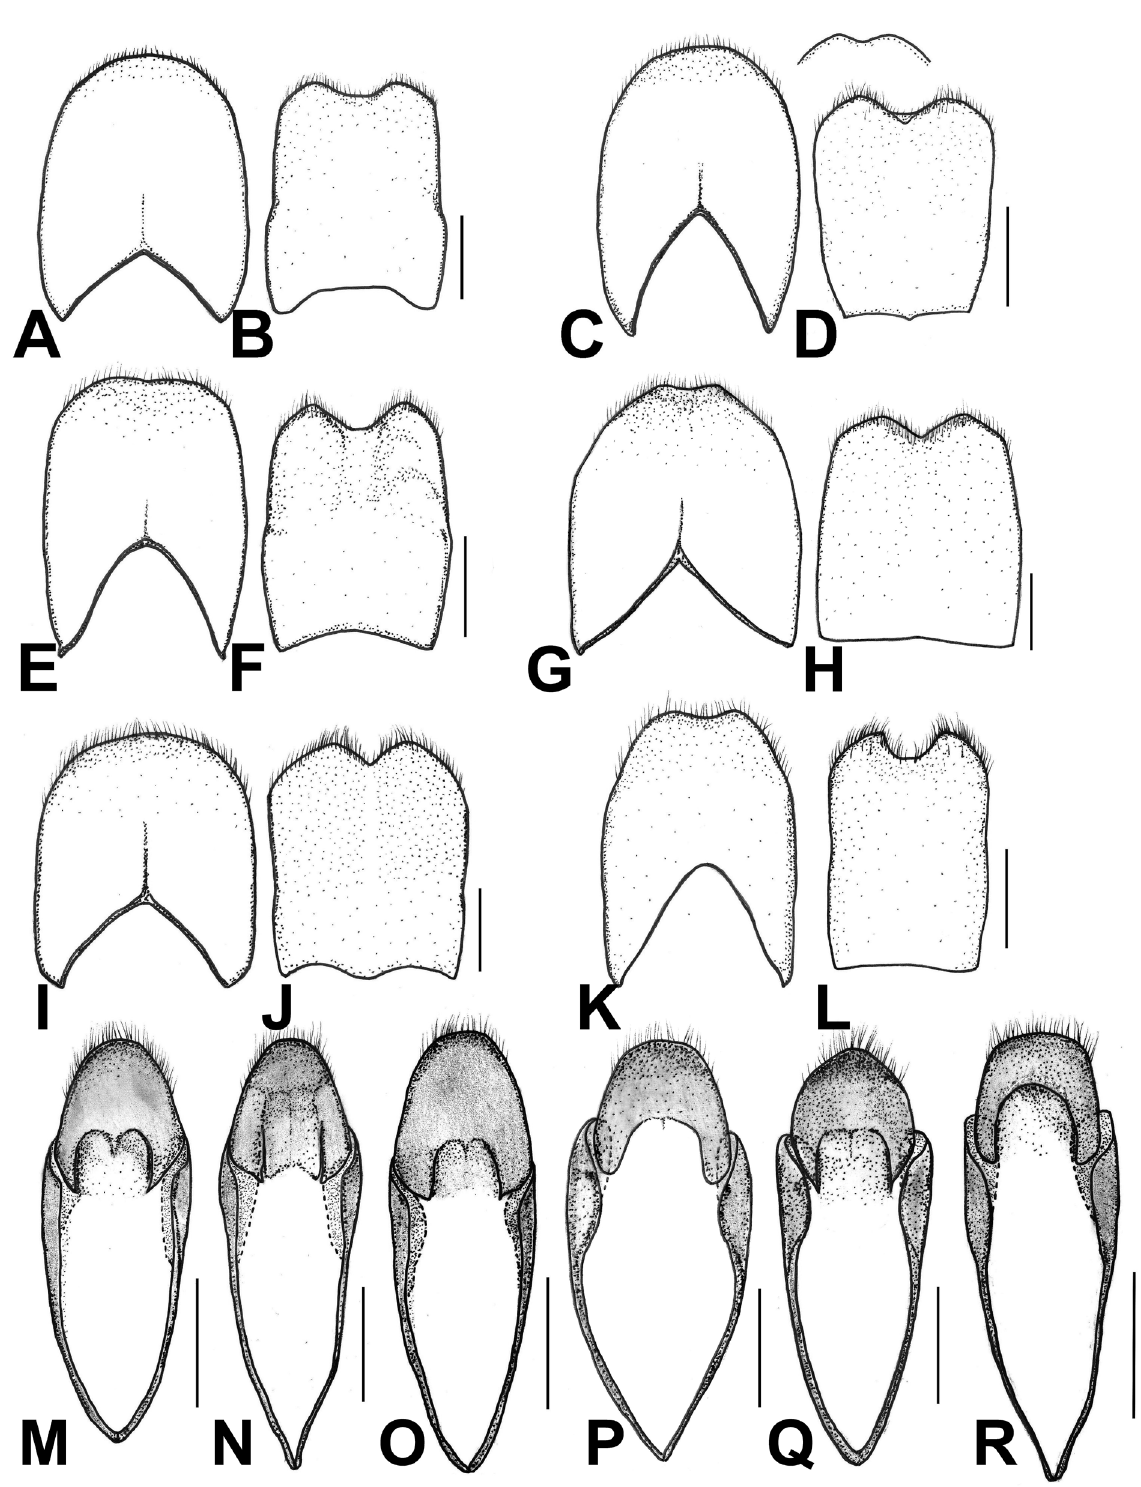
Fig. 5. Abdominal sternite VIII–IX and tergite VIII–X of ♂♂. A , C , E , G , I , K . Abdominal tergite VIII. B , D , F , H , J , L . Abdominal sternite VIII. M–R . Abdominal sternite IX, and fused tergite IX and X. — A–B , M . Synchroa punctata Newman, 1838. C–D , N . S. melanotoides Lewis, 1895. E–F